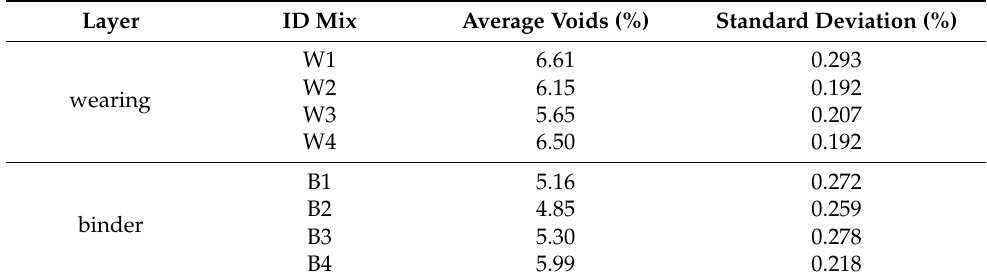
Table 3. Air voids of the mixtures.